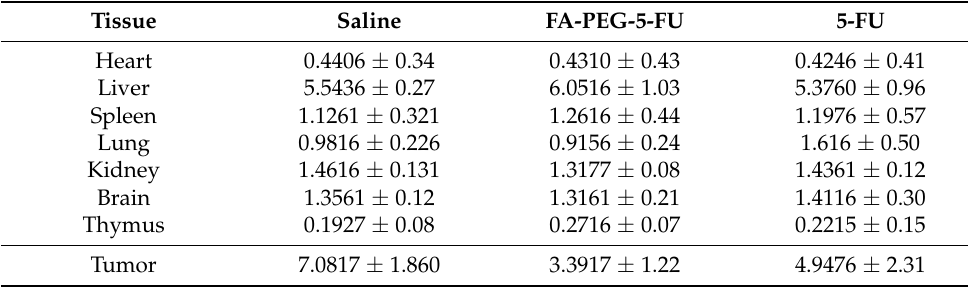
Table 1. Index of organ to body weight ( n = 6, mean ± SD). Tissue Saline FA-PEG-5-FU 5-FU